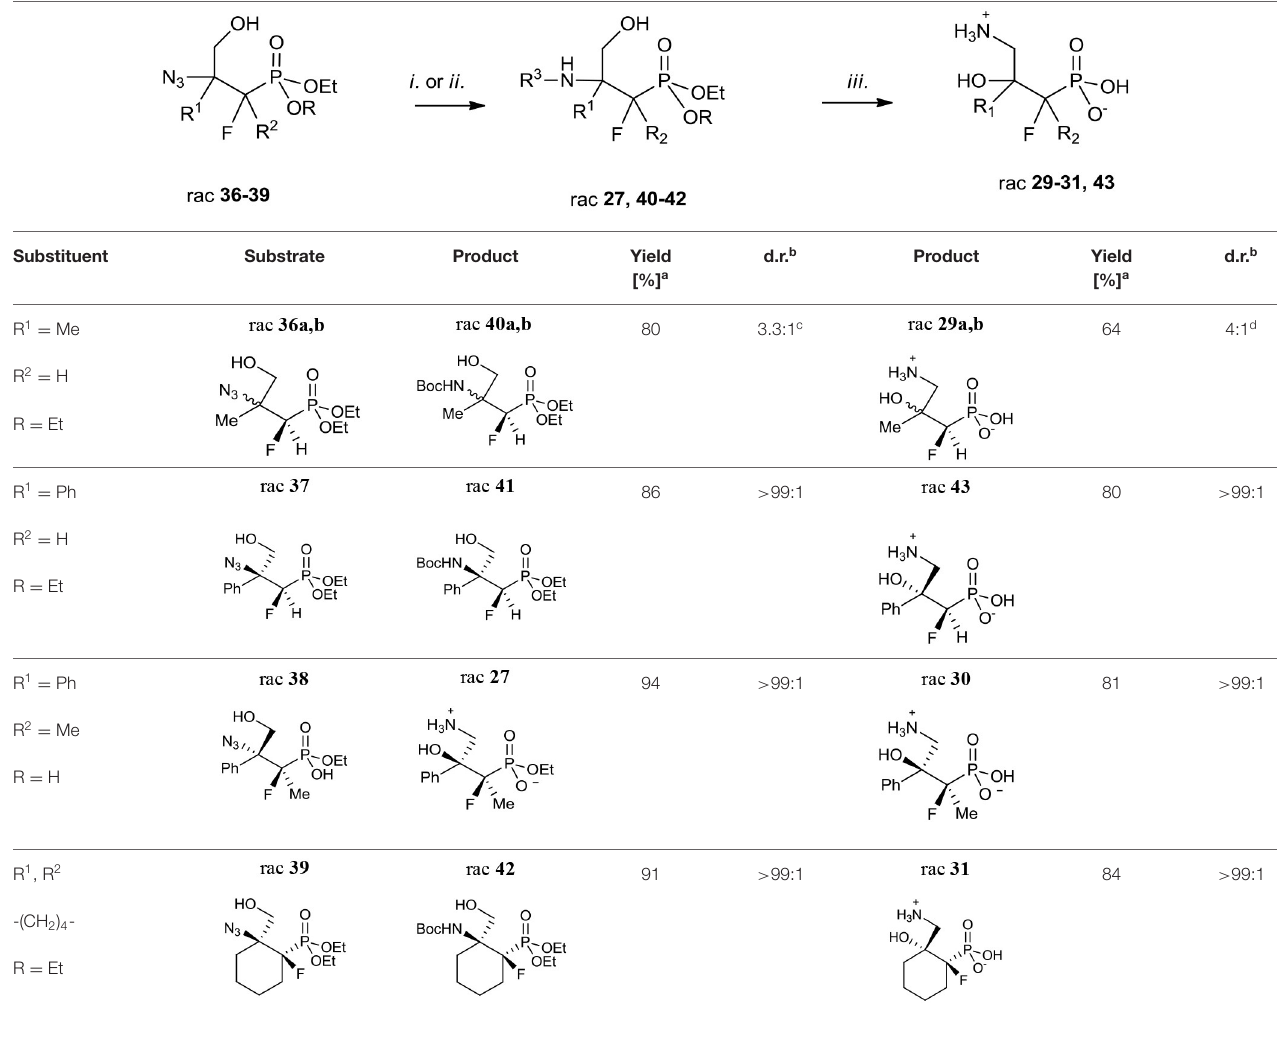
TABLE 7 | Synthesis of fluorinated γ -amino- β -hydroxy alkylphosphonic acids 29–31 and 43 .